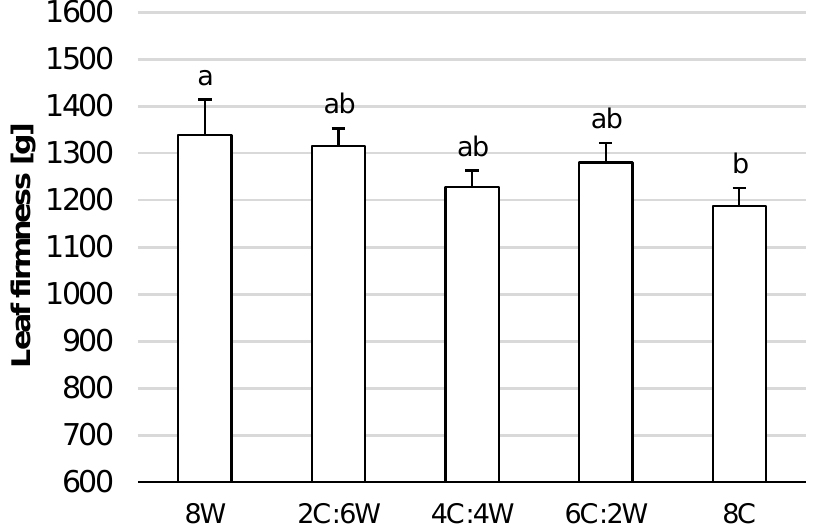
Figure 12. Effect of growing media ratio on leaf firmness (g), 35 days after transplant. Vertical bars denote standard error. Different letters denote significant difference according to the Student’s t -test at p ≤ 0.05.